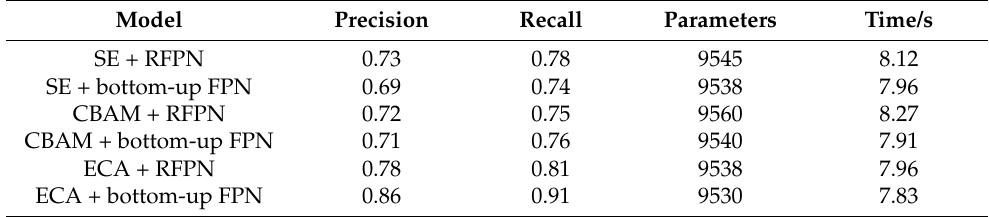
Table 6. The evaluation values of the six models in